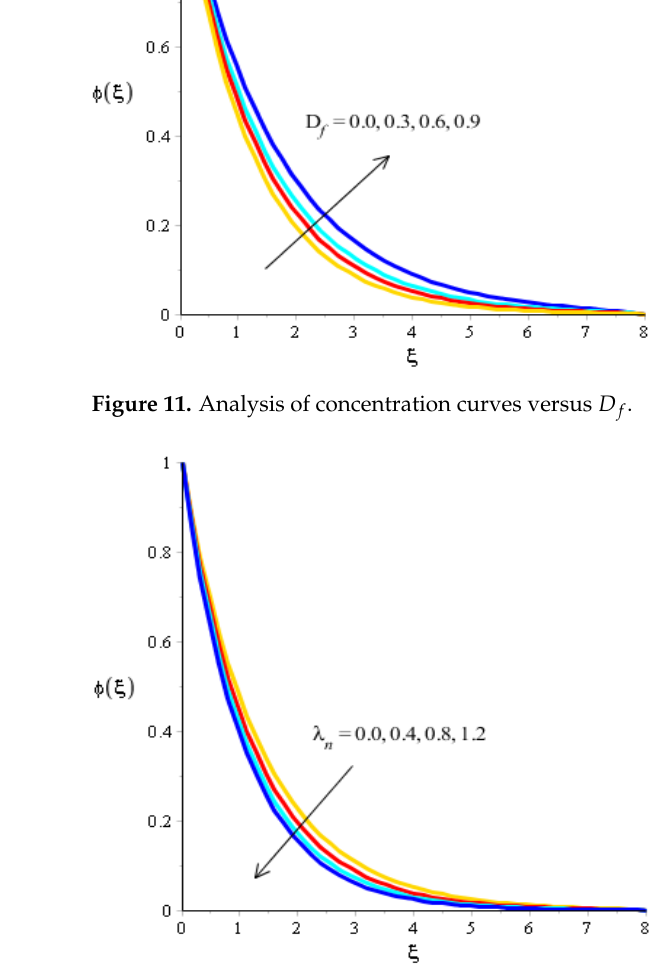
Figure 14. Analysis of concentration curves versus 𝐾 (cid:3030) . 5. Conclusions A finite element scheme was engaged for handling the modelled physical problem which was past over a stretching sheet containing a mixture of nanoparticles in a pseudo- plastic material under the Soret and Dufour effects. Several important plots were dis- played to capture the features of different parameters involved in the fluid velocity, tem- perature, and concentration fields. Important findings are listed below: •